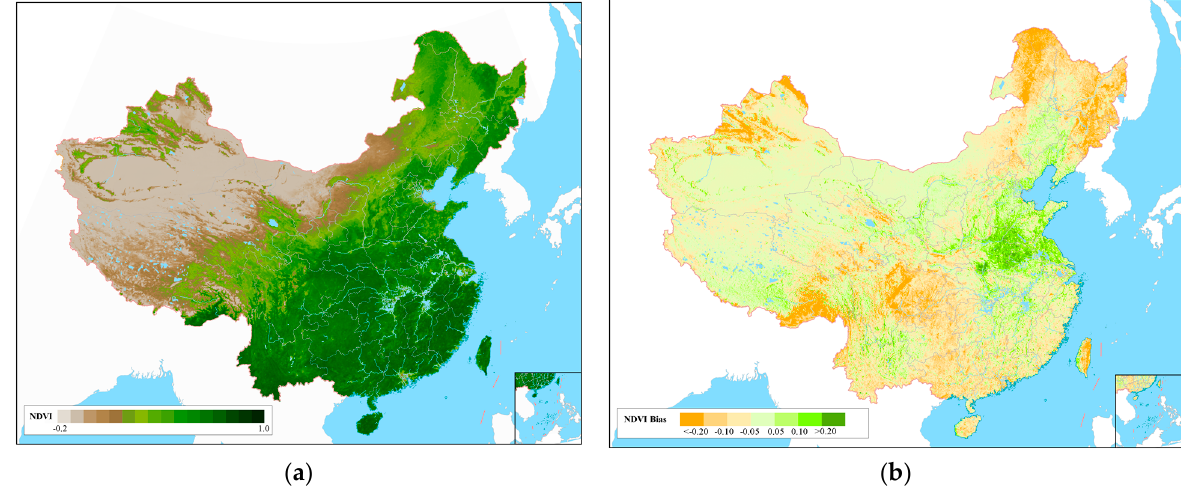
Figure 3. The spatial distribution of annual FY3D MERSI-II NDVI bias ( a ) and annual FY3D NDVI bias based on MODIS NDVI ( b ) during 2020 and 2021.